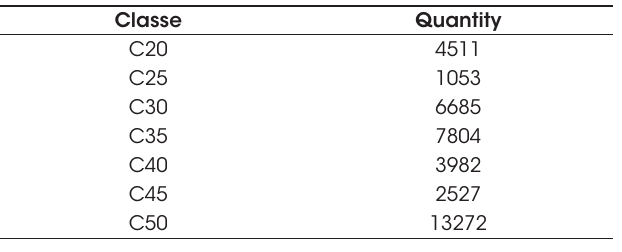
Quantification of specimens by concrete class